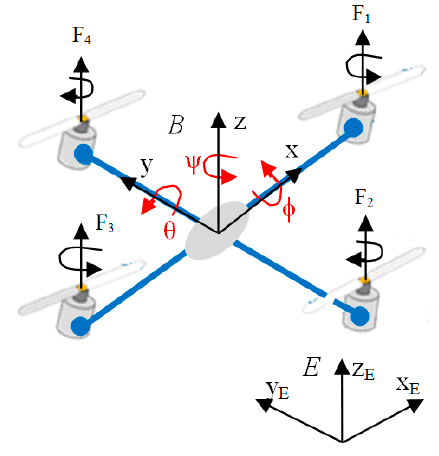
Figure 1. Quadrotor’s configuration.